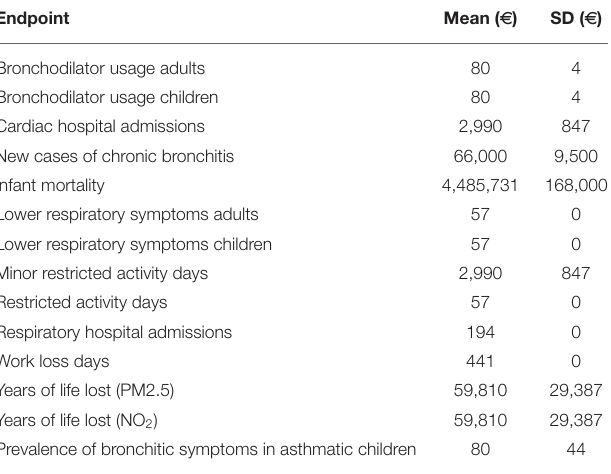
TABLE 4 | Monetary values for health impact